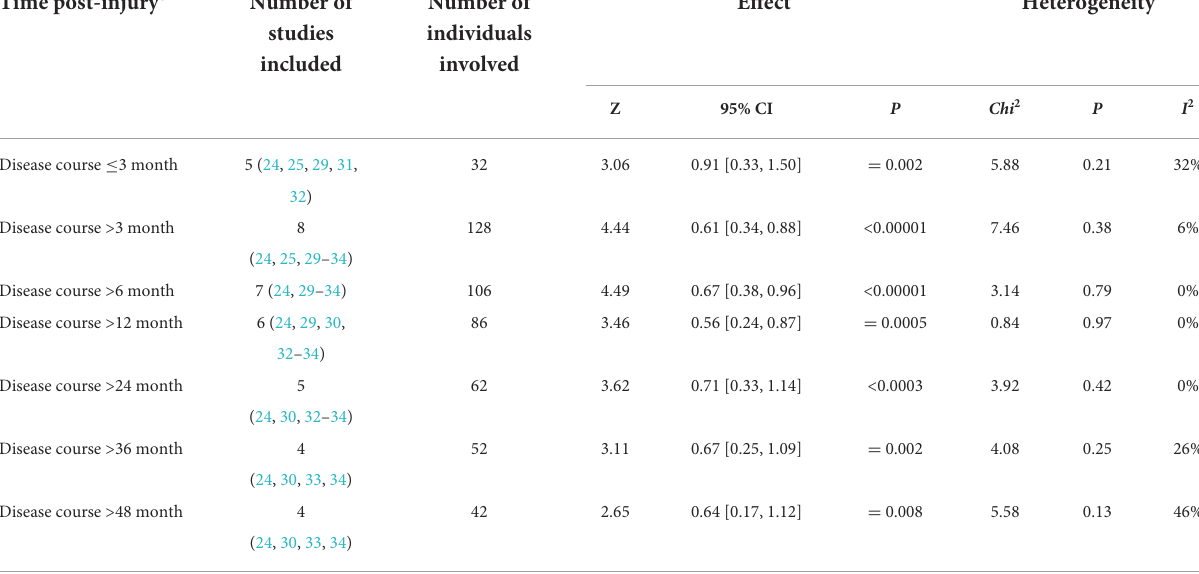
TABLE 4 Subgroup analysis of different disease